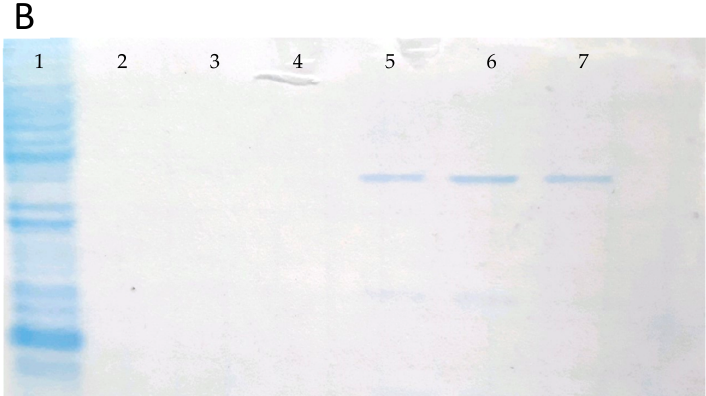
Figure 2. Panel ( A ). Western blot of the BL21(DE3) pLysS (Promega™) E. coli cells transformed with the pET-14b_gspDLC recombinant expression vector and induced with 1 mM IPTG (lanes 1–6). Lane 7, uninduced control. An approximately 63 kDa band was observed corresponding to the rGspDLC protein reactive to an anti-His monoclonal antibody. Panel ( B ). Coomassie blue-stained acrylamide gel, showing the rGspDLC purified by Ni-affinity chromatography and sodium phosphate/urea elution buffer. Lane 1, recombinant E. coli lysate; lanes 5, 6, and 7 show the purified recombinant protein.